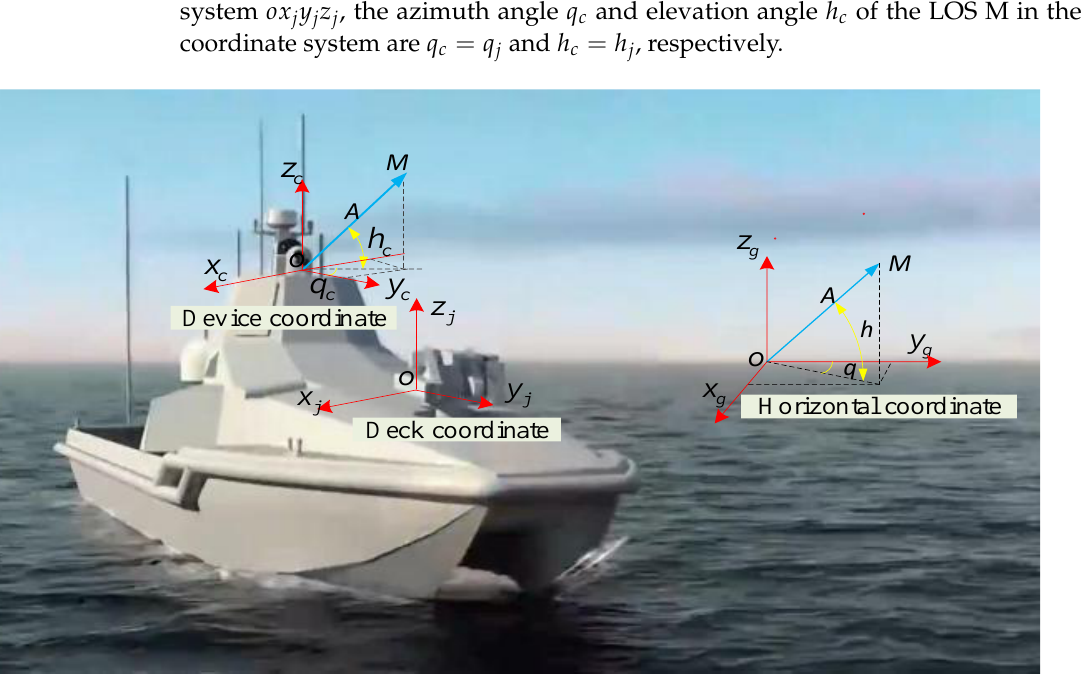
Figure 1. The device coordinate system and the deck coordinate system. To ensure that the LOS is pointing to M on the sea–sky line, the electro-optical device o x j must be rotated in the azimuth and elevation directions relative to the device coordinate system by angles ∆ q = q c and ∆ h = h c , respectively. Thus, the shaking of the captured im- ages caused by the swaying of the carrier can be eliminated to realize the LOS stabilization function in the horizontal coordinate system. When the elevation angle h is zero, the center of the images captured by the electro-optical device is always stable on the sea–sky